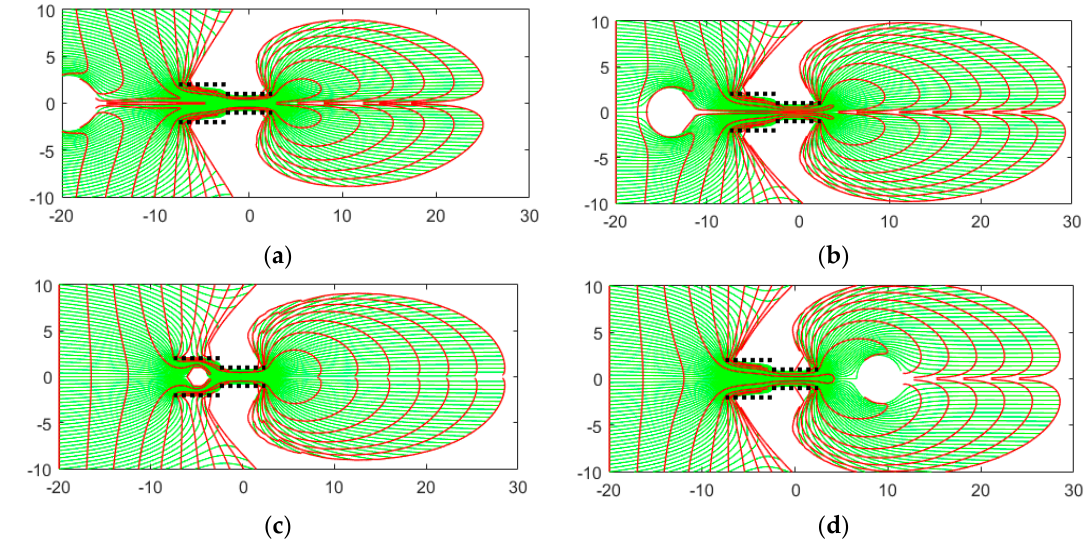
Figure 18. Movement of an active ganglion through a micro-channel. From left to right, top to bottom: ( a ) The initial/reference position of the ganglion. ( b – d ) Position and shapes of the ganglion at 60, 180, and 300 s, respectively. The radius of the starting ganglion is 4 × 10 − 6 m. The dimensions of the pores, strength, and duration of simulation are the same as in Figure 4, 5. The strength of the dipole is 10 times the strength of the far-field flow. Length units are scaled in μ m (both x-axis and y-axis).